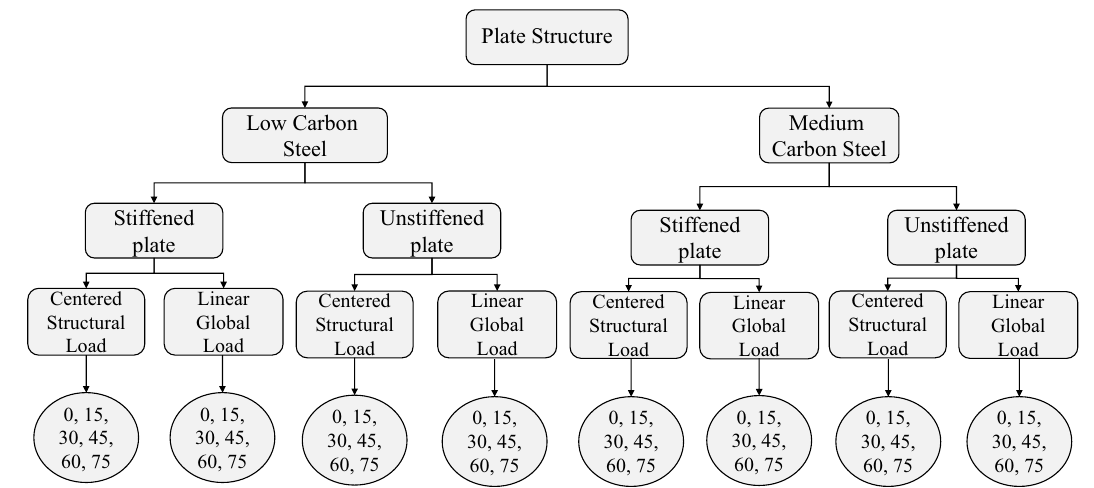
Figure 3: Diagram of the simulation variation